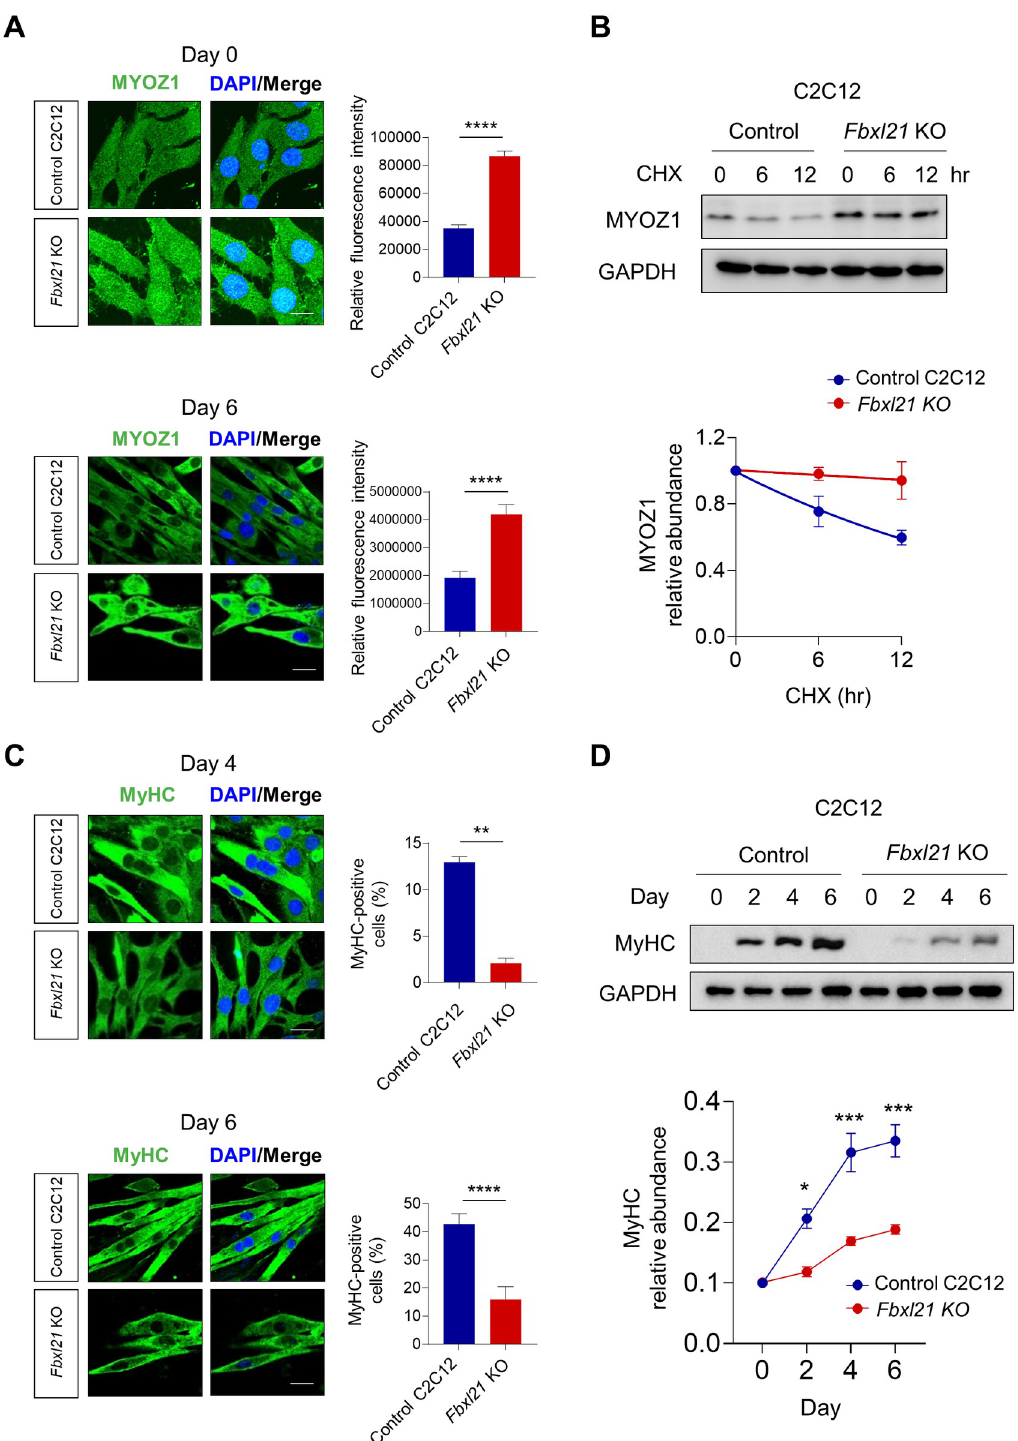
Fig 3. Fbxl21 deletion leads to MYOZ1 accumulation and inhibits C2C12 myoblast differentiation. (A) MYOZ1 staining of control and Fbxl21 KO C2C12 cells in myoblasts (differentiation Day 0) and myotubes (Day 6). Right panels: MYOZ1 fluorescence intensity quantification at day 0 and day 6. Data are presented as mean ± SEM (n = 3), ���� p < 0.0001; t-test. control vs. Fbxl21 KO C2C12 cells. Scale bar, 15 μ m. (B) Analysis of MYOZ1 protein stability in control and Fbxl21 KO C2C12 myoblasts by CHX chase assays. Lower panel: quantification of MYOZ1 stability. Half-life of MYOZ1: 15.8 hrs (control